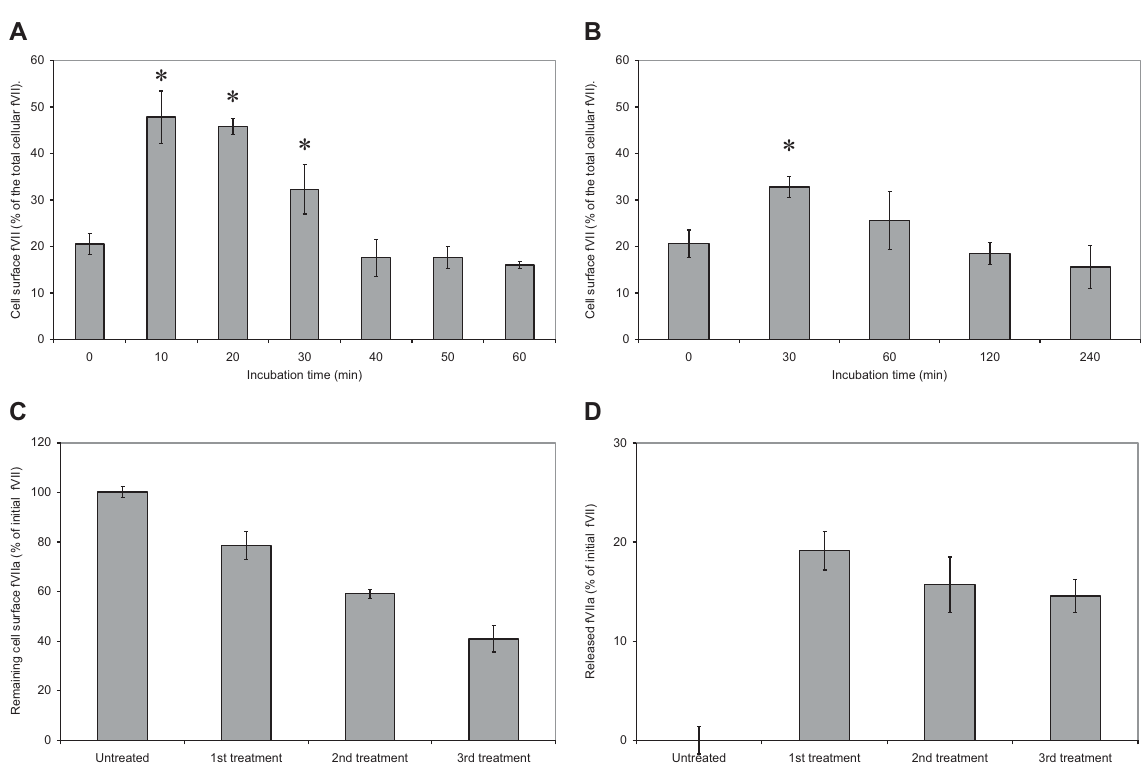
Fig.7 HCAECs express fVIIa on the cell surface in response toTFand PAR2 activation. Two separate sets of HCAEC (2 (cid:1) 10 4 ) were incubated with ( A ) TF (2 U/mL) or ( B ) PAR2-activating peptide (20 µM) for the durations shown and the cells were then fi xed using 4% (v/v) formaldehyde. The cells were washed and one set was permeabilized while the other kept intact. Total and surface expression of fVII were measured in situ, by incubating all samples with a mouse anti-fVIIa antibody (20 µg/mL). The samples were then probed with a HRP-conjugated goat antimouse antibody (dilute 1:1000 v/v) and developed using the TMB substrate. The percentage ratio of surface:total fVII was then calculated ( n ¼ 5; (cid:4) ¼ p < 0.05 vs. the observed ratio at time zero). HCAECs (2 (cid:1) 10 4 ) were also subjected to repeated treatment with recombinant TF (2 U/mL) at 60 minute intervals. After each treatment, the relative amount of ( C ) cell-surface fVII antigen and ( D ) the released microvesicle-associated fVII antigen were measured and the percentages were calculated against the amount of cell-surface fVII in the untreated cells. HCAEC, human coronary artery endothelial cells; PAR2, protease-activated receptor-2; TF, tissue